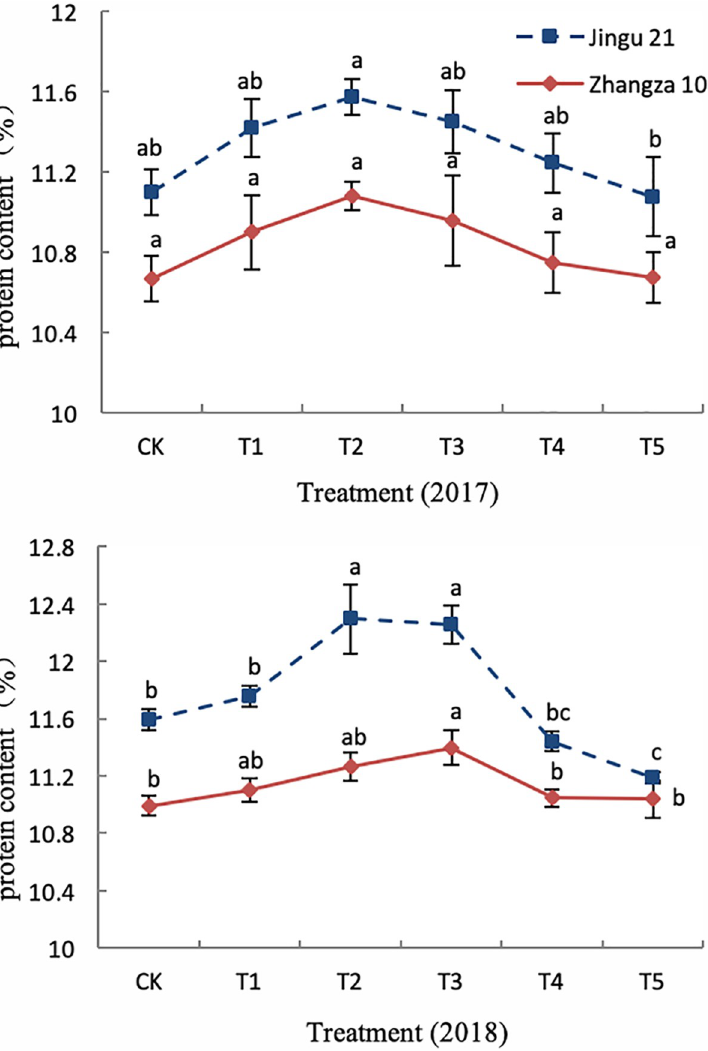
Fig 2. Effect of humic acid on protein content of foxtail millet in the years 2017 and 2018. CK, T1, T2, T3, T4, and T5 on the x-axis represent HA concentrations (0 mg L -1 , 50 mg L -1 , 100 mg L -1 , 200 mg L -1 , 300 mg L -1 , and 400 mg L - 1 ); y-axis represents protein content. Lowercase letters in the same column indicate significant differences at the 0.05 level.